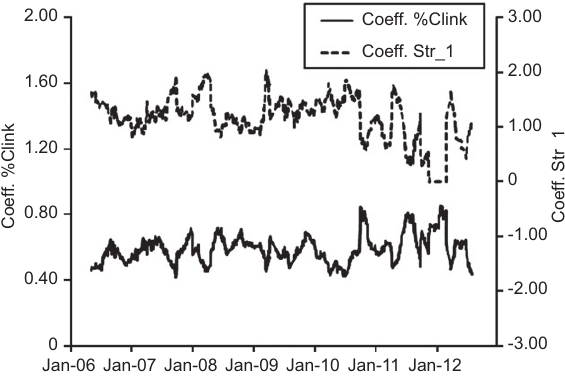
The average residual errors of the movable horizon